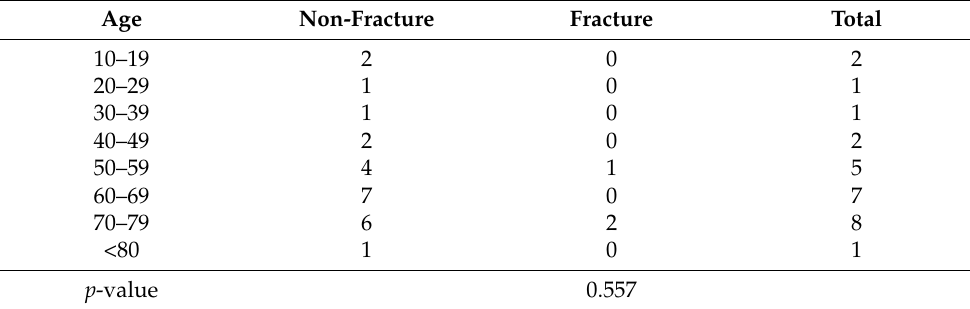
Table 2. Classification of patients by